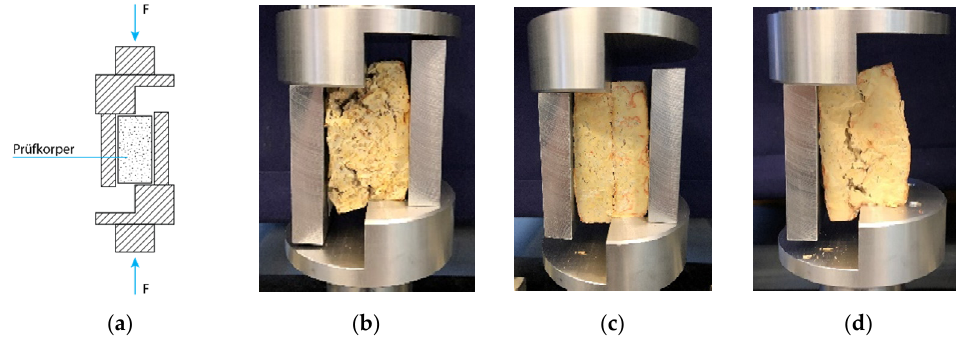
Figure 4. ( a ) Conceptual illustration describing the testing setup. Test specimens being tested under DIN-EN Standards: ( b ) Sch0, specimen with no binding interface; ( c ) Sch1, specimen with planar binding interface; and ( d ) Sch3, specimen with big jagged interface.